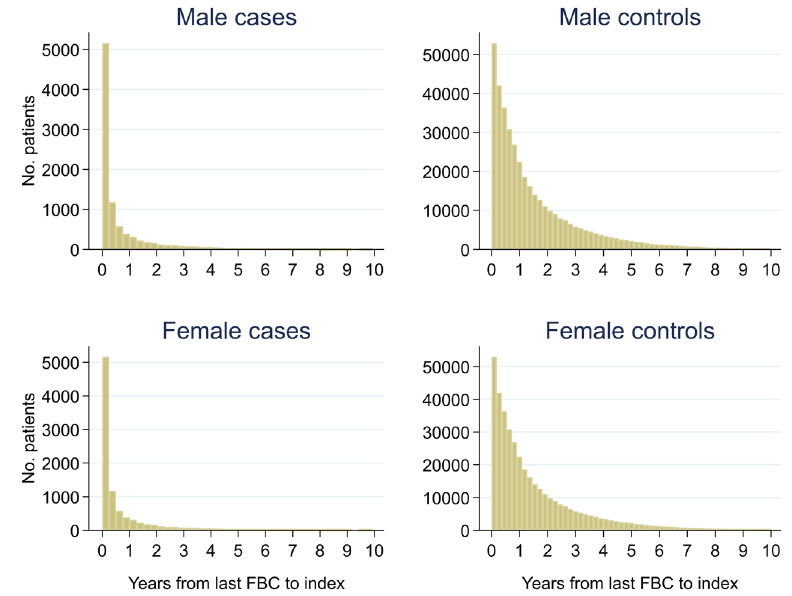
Figure 3. Histogram of time between last FBC and index date 1,2 . 1 Index date was the date of diagnosis for cases and a randomly selected date in the patient’s study period for controls. 2 The spike at time=0 in cases is likely due to patients undergoing cancer investigation. This was not expected to influence trends, as the trends rely on sufficient data at each time-point, not comparability of